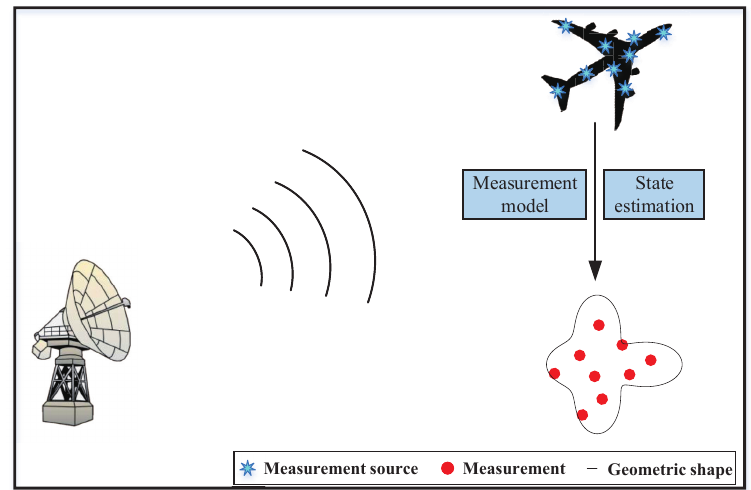
Figure 1. Status diagram of radar object